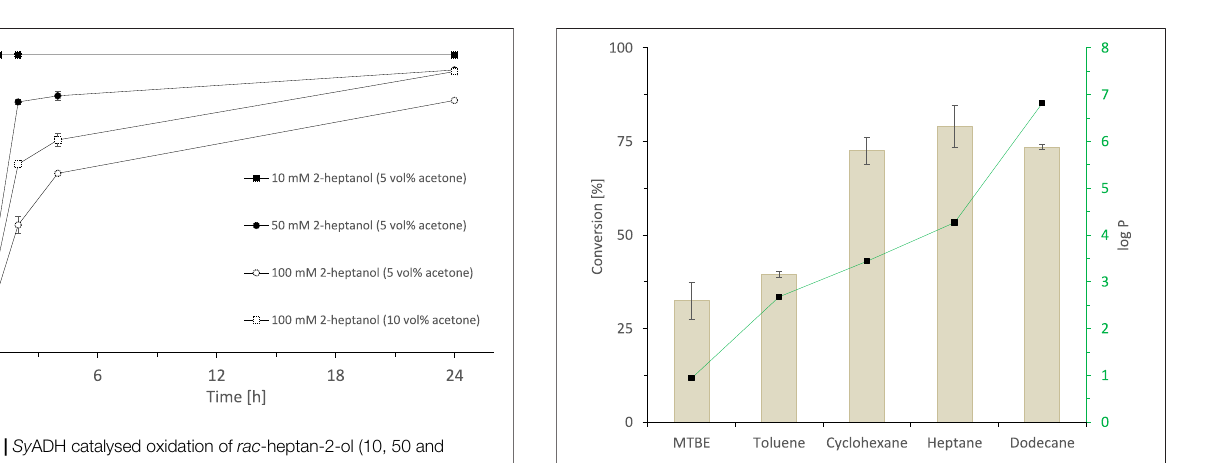
FIGURE 4 | The effect of hydrophobicity of organic solvent (expressed aslog p values( ■ ))ontheactivityof Sy ADH-catalysedoxidationof rac -heptan- 2-olinbiphasicreactionsystems.Reactionconditions:[ rac -heptan-2-ol] organic phase = 50 mM, [ethyl acetoacetate] organic phase = 100 mM (2 equiv.), [NADP + ] aq = 1 mM, [ E. coli C43 (DE3) pET24b- syadh ] aq = 10 mg × mL − 1 , [KPi, pH 7] = 1 M (10% v/v), [organic solvent] = 90% v/v, total volume: 500 μ L, T = 30 ° C, reaction time: 24 h, 600 rpm. Data are expressed as the mean ± SD of the two independent experiments performed in technical